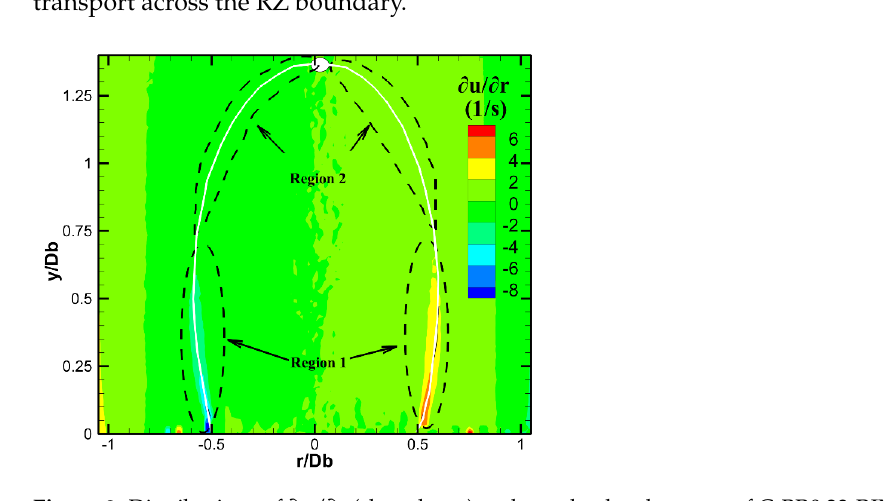
Figure 9. Distributions of ∂u/∂r (shear layer) at the wake development of C-BR0.23-RIM2 configuration and topology of zero streamline.